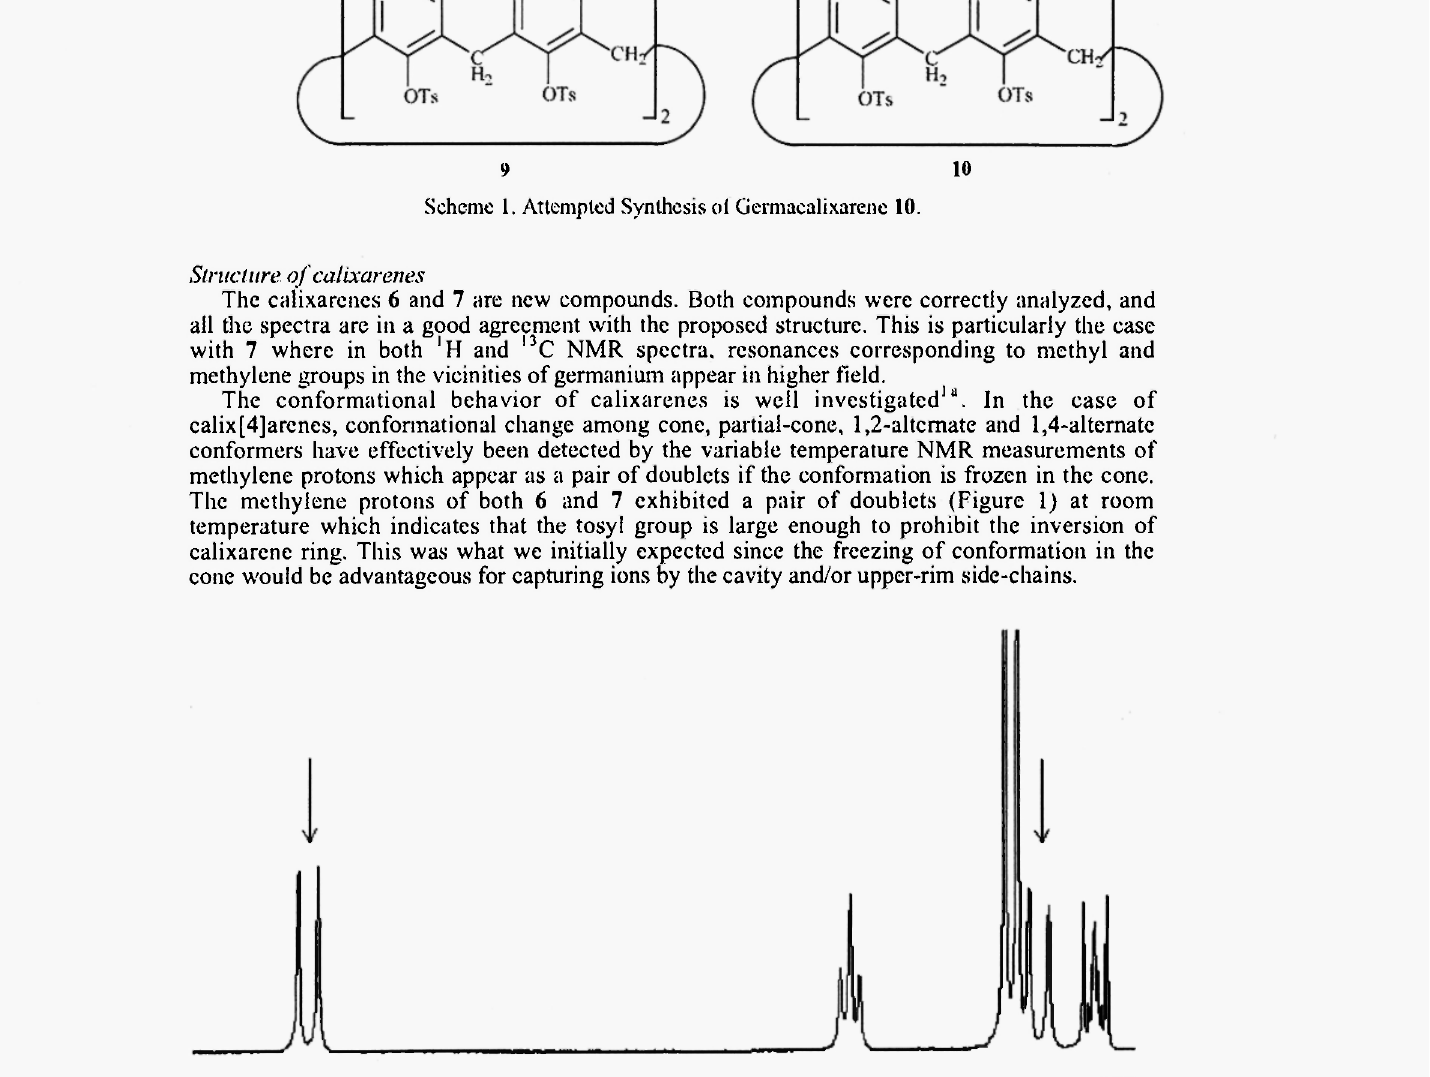
Figure I. Methylene Portion of Ή NMR Spectrum of 7. (partly overlapped by Me signal of tosyl group) Cation transport